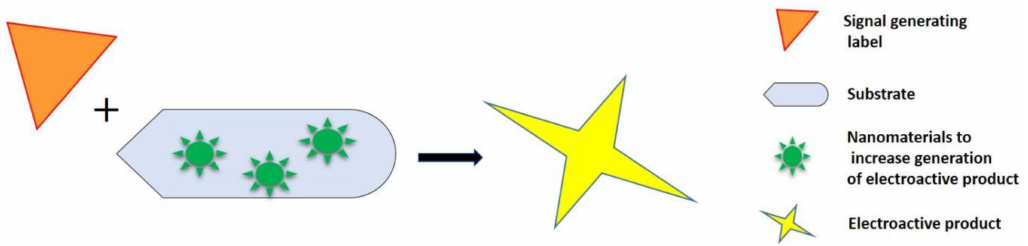
Figure 3. Integration of nanomaterials towards signal amplification of electrochemical